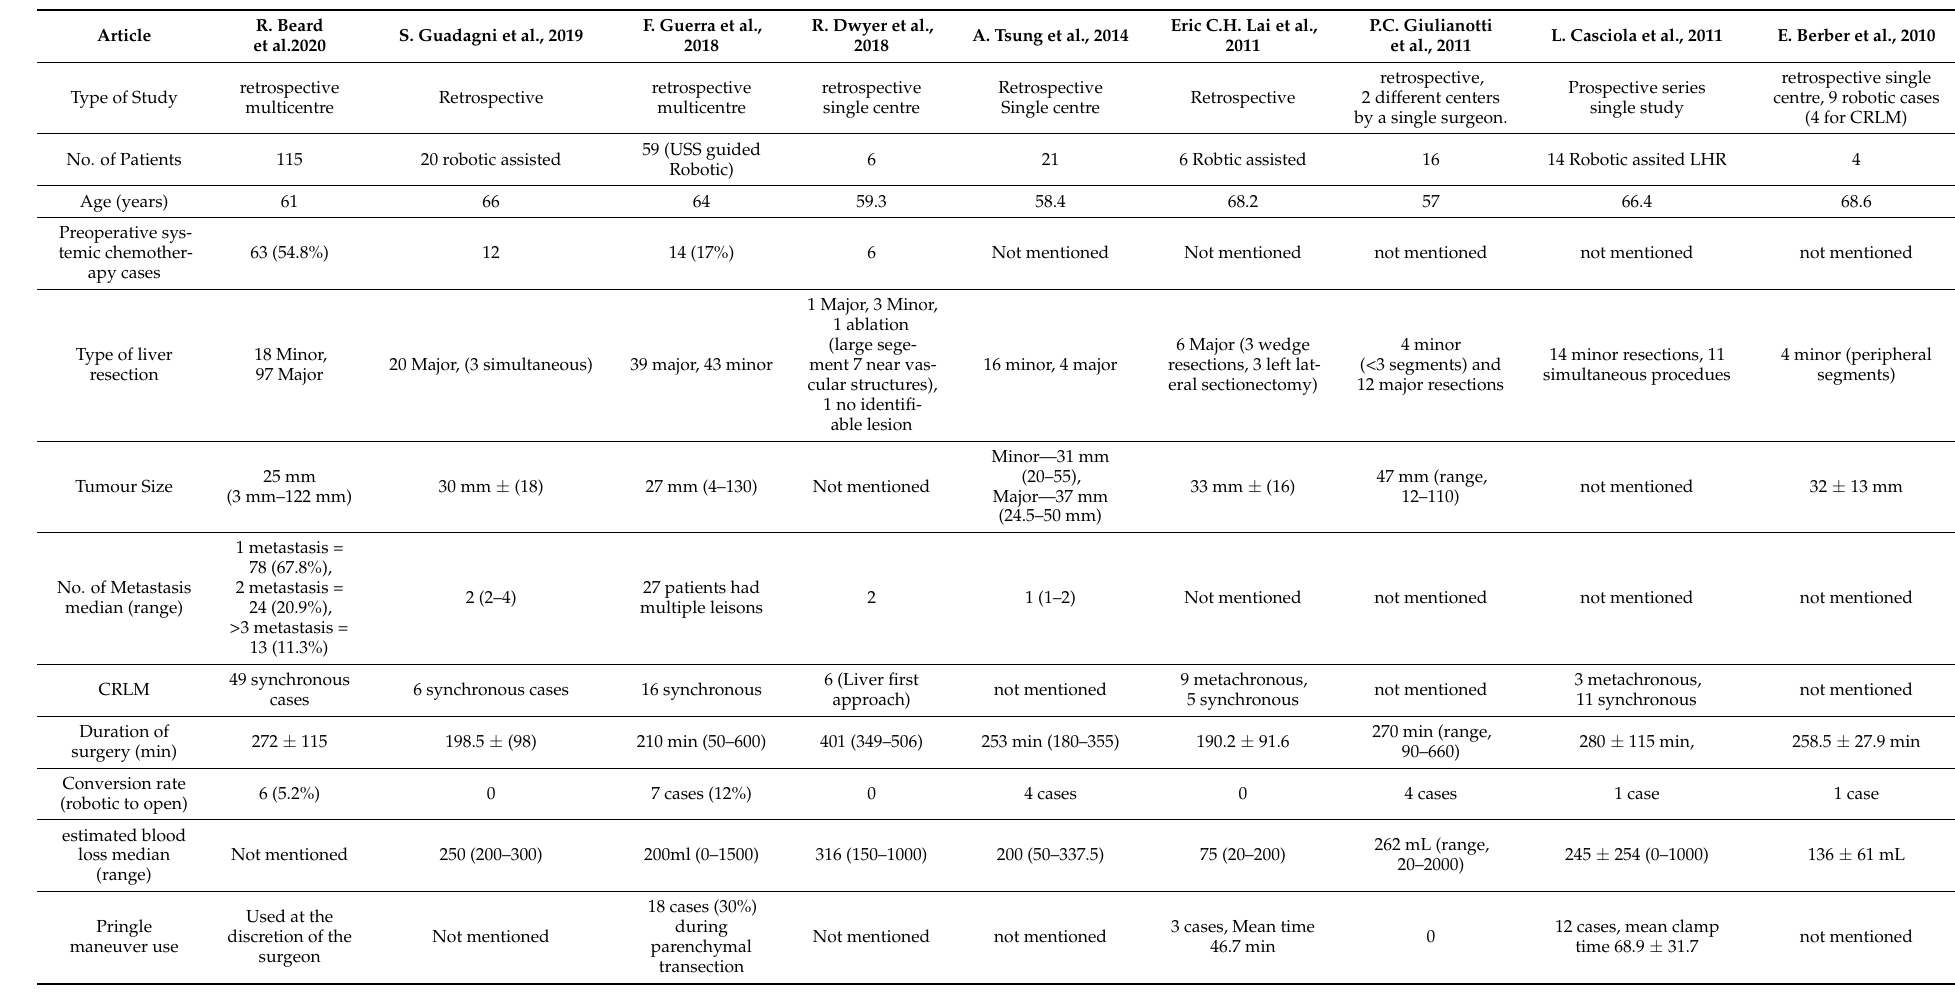
Table 2. Outcomes of the Robotic Liver Resections for